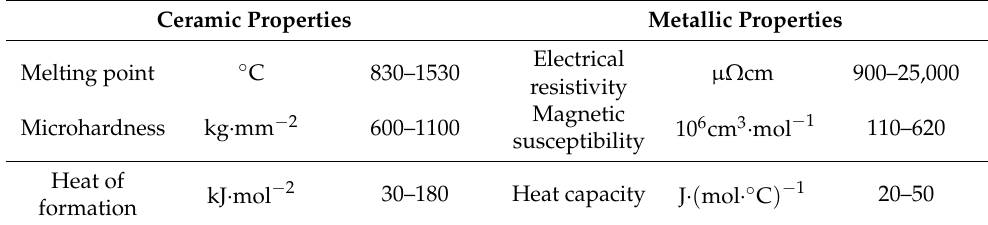
Table 2. Physical properties of metal-rich phosphides.